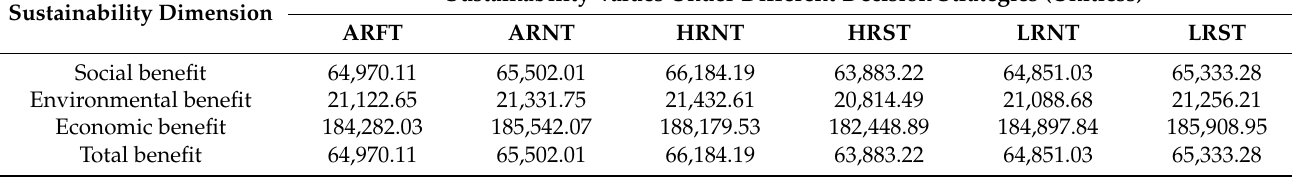
Table 7. Sustainability benefit values under different decision